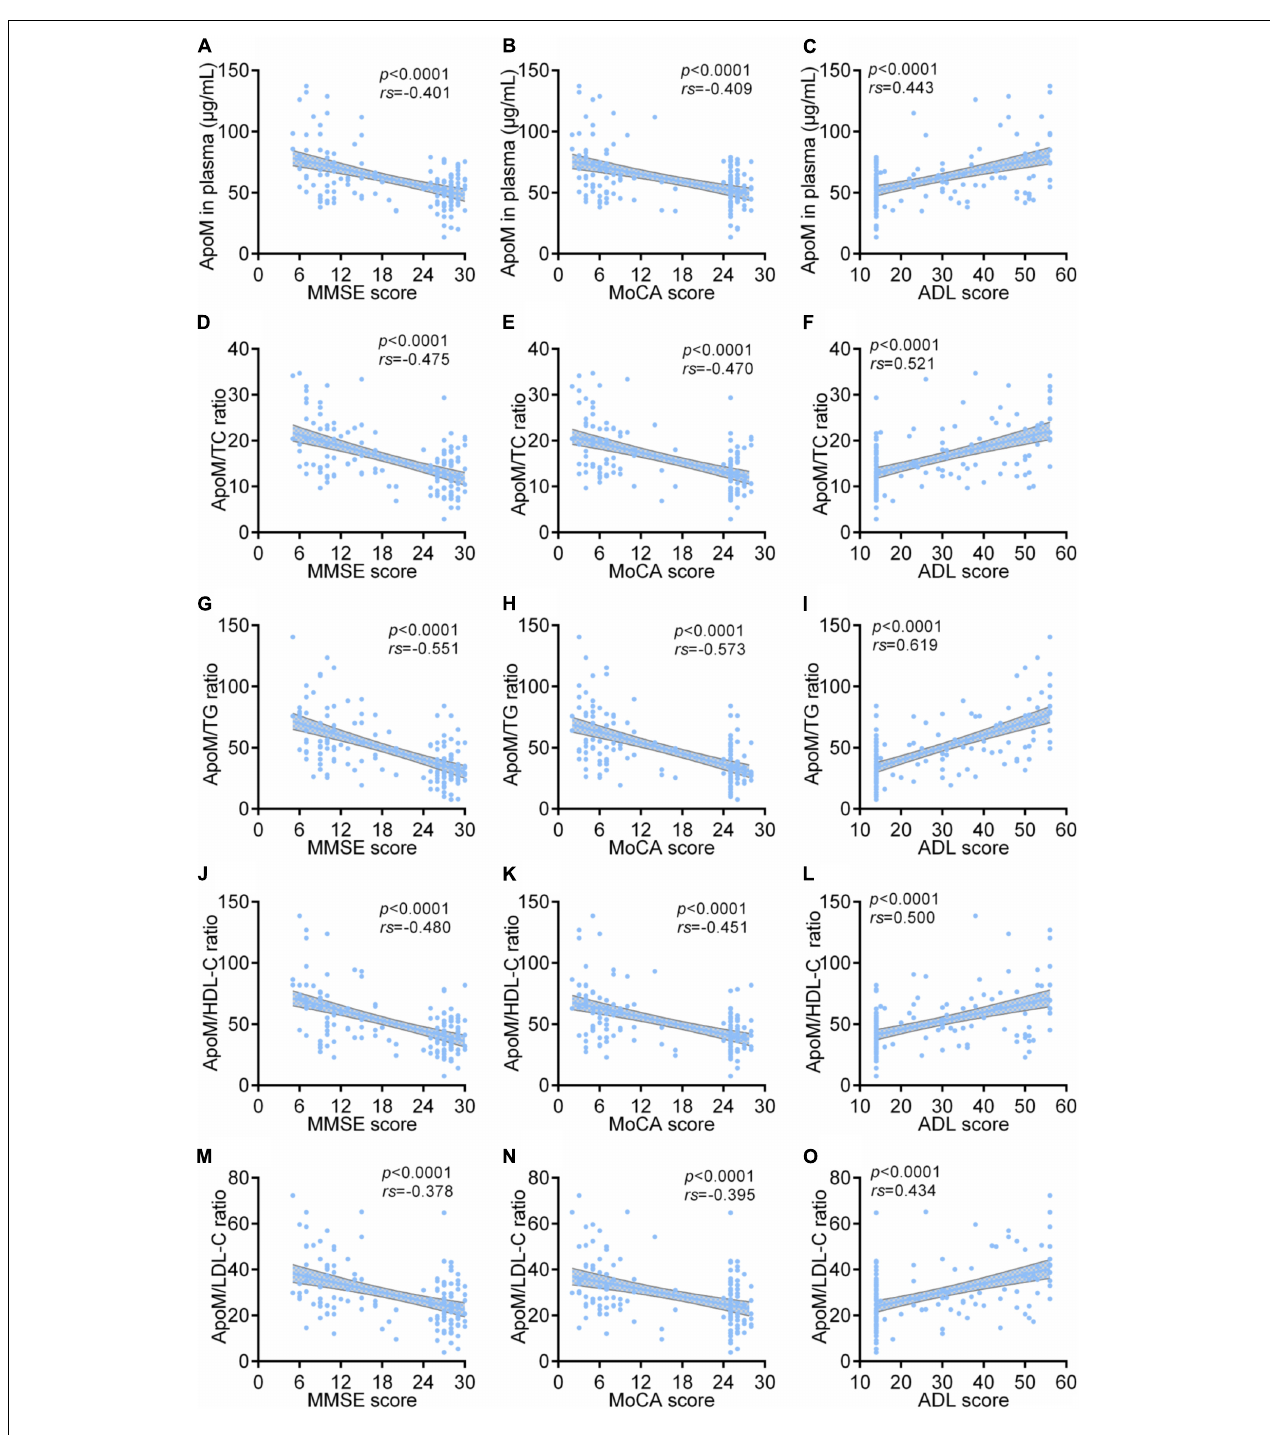
FIGURE 2 | Correlations between plasma ApoM and its derived indicators with clinical characteristics of AD among all participants. The correlations between plasma ApoM with MMSE score (A) , MoCA score (B) and ADL score (C) . The correlations between ApoM/TC ratio with MMSE score (D) , MoCA score (E) and ADL score (F) . The correlations between ApoM/TG ratio with MMSE score (G) , MoCA score (H) and ADL score (I) . The correlations between ApoM/HDL-C ratio with MMSE score (J) , MoCA score (K) and ADL score (L) . The correlations between ApoM/LDL-C ratio with MMSE score (M) , MoCA score (N) and ADL score (O) . ApoM, apolipoprotein M; AD, Alzheimer’s disease; MMSE, Mini–Mental State Examination; MoCA, Montreal Cognitive Assessment; ADL, activities of daily living; TC, total cholesterol; TG, triglyceride; HDL-C, high-density lipoprotein cholesterol; LDL-C, low-density lipoprotein cholesterol. Correlation analyses were performed using Spearman’s rank correlation. p < 0.05 was considered the statistical